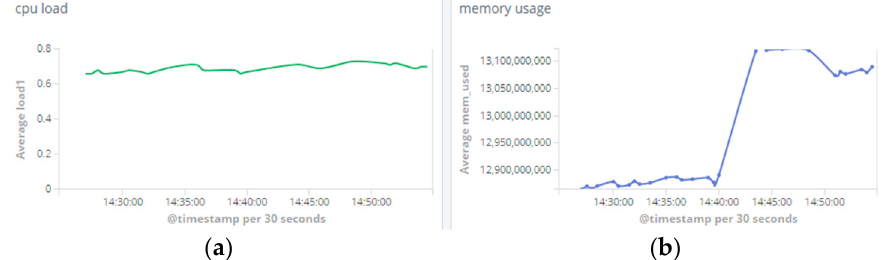
Figure 11. Visibility data collection overhead for packet-precise network flows. ( a ) CPU load and ( b ) memory utilization.